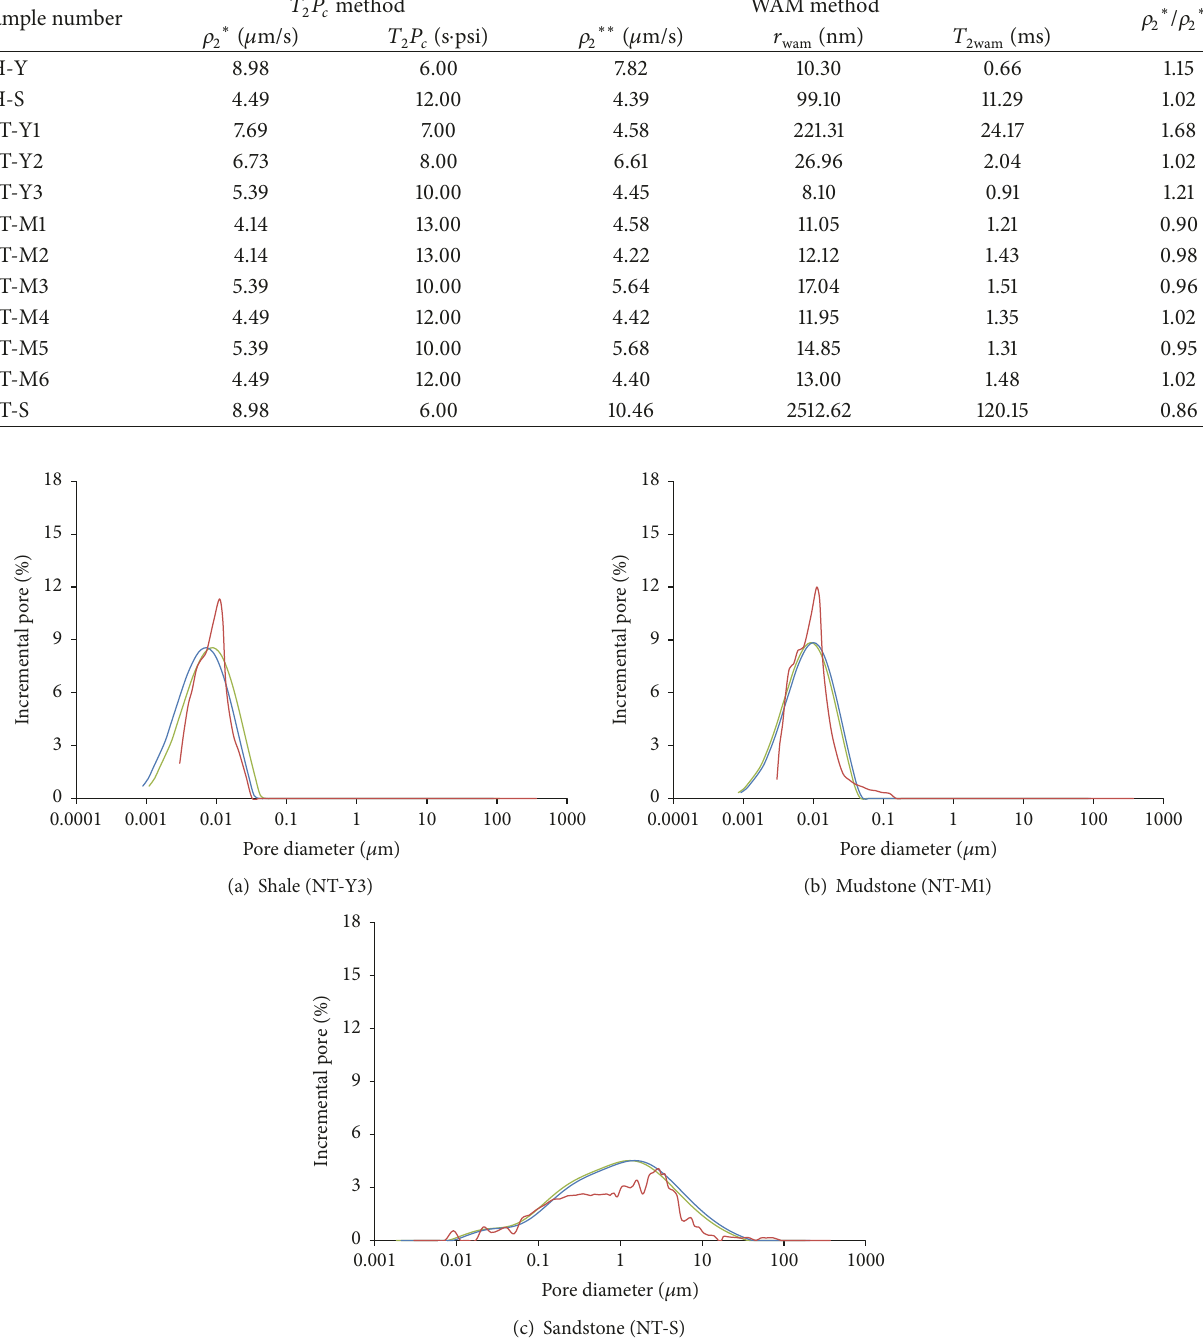
Figure 9: Comparisons of NMR PSD curves of typical shale, mudstone, and fine-grained sandstone samples calibrated by the 𝑇 2 𝑃 𝑐 (green line) and weighted arithmetic mean (WAM) (blue line) methods with MIP PSD curves (red